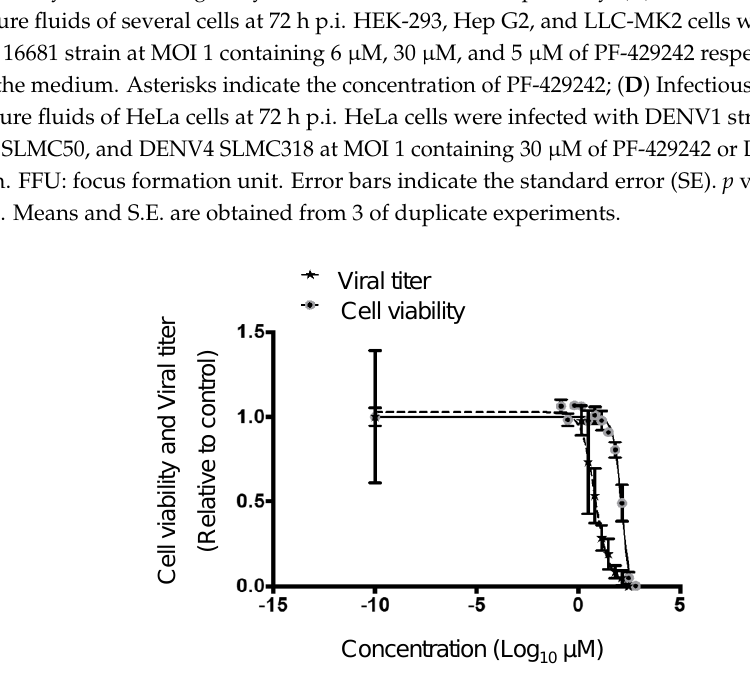
Figure 2. Cytotoxicity and inhibitory concentrations of PF-429242 in HeLa cells infected with DENV. HeLa cells were treated with 3 to 300 µM of PF-429242, and intracellular ATP was measured after 72 h. HeLa cells were infected with the DENV2 16681 strain at MOI 0.001 containing 1.4 to 300 μM of PF-429242 or DMSO alone in the medium, and infectious viral titers in the supernatant were measured after 72 h. The X-axis indicates the concentrations of PF-429242 and the Y-axis indicates the relative values compared with the control. Error bars indicate the S.E. Means and SE are obtained from 3 of duplicate